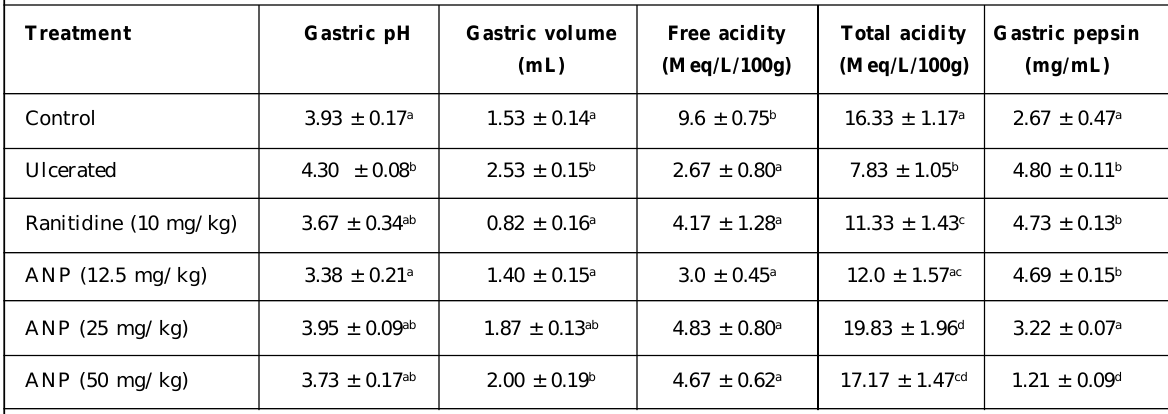
Note: Data are means of six replicates ± SEM. Values with different superscript down the same column are significantly different ( p < 0.05); ANP: Acacia nilotica seedpod.